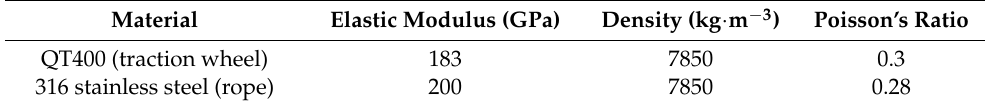
Table 2. Material parameters of the traction wheel and wire rope.